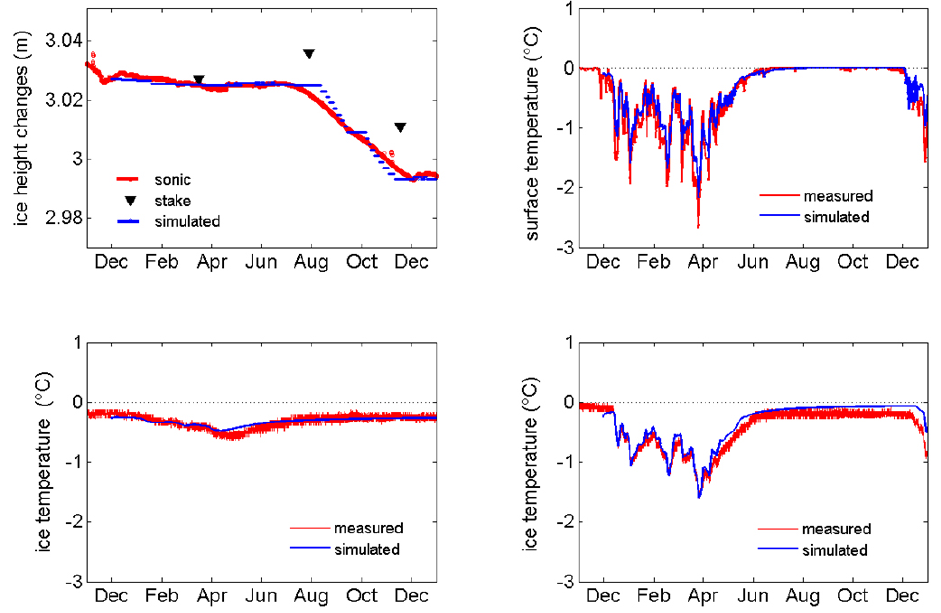
Fig. 6. The development of changes in ice thickness and surface temperature (upper panels) and of ice temperatures 3m and 0.5m below the ice surface (lower panels).